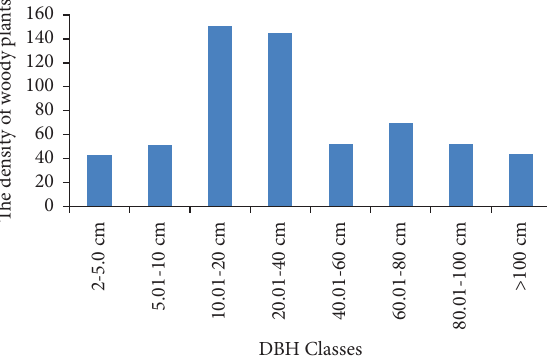
Figure 4: General DBH distribution patterns (structure) of Saleda Yohans Church